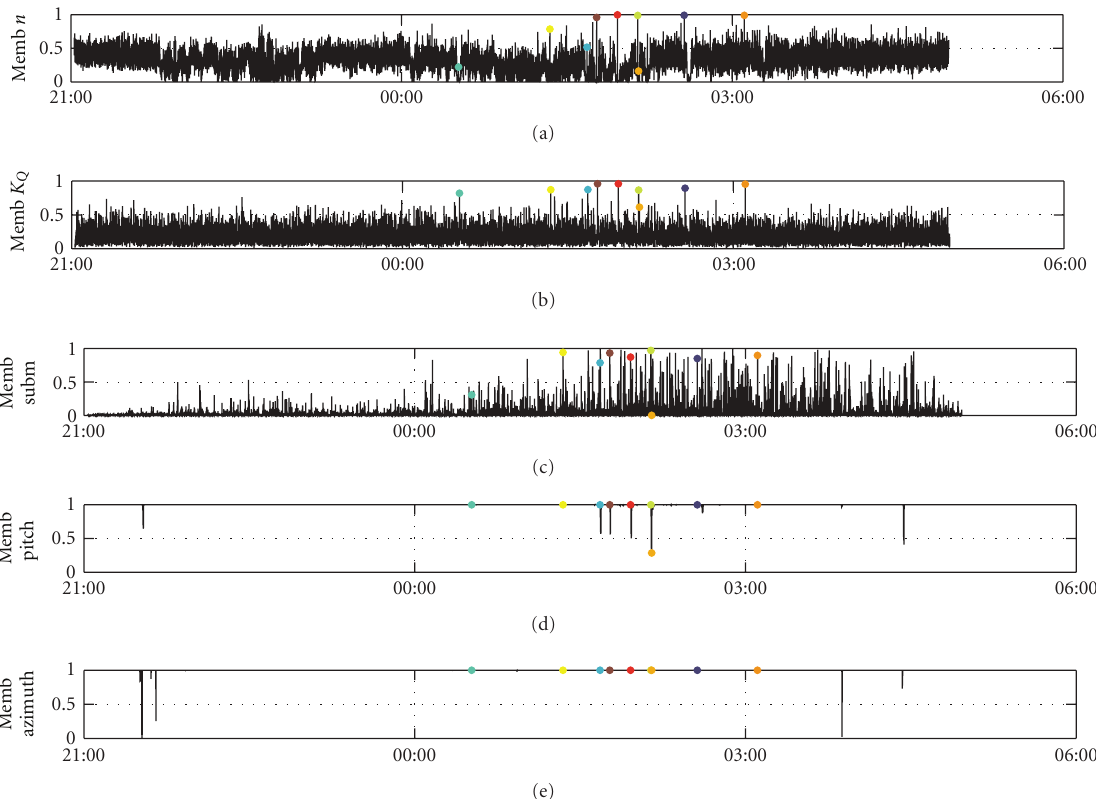
Figure 8: Calculated membership function for the analyzed time series, showing the marked points.